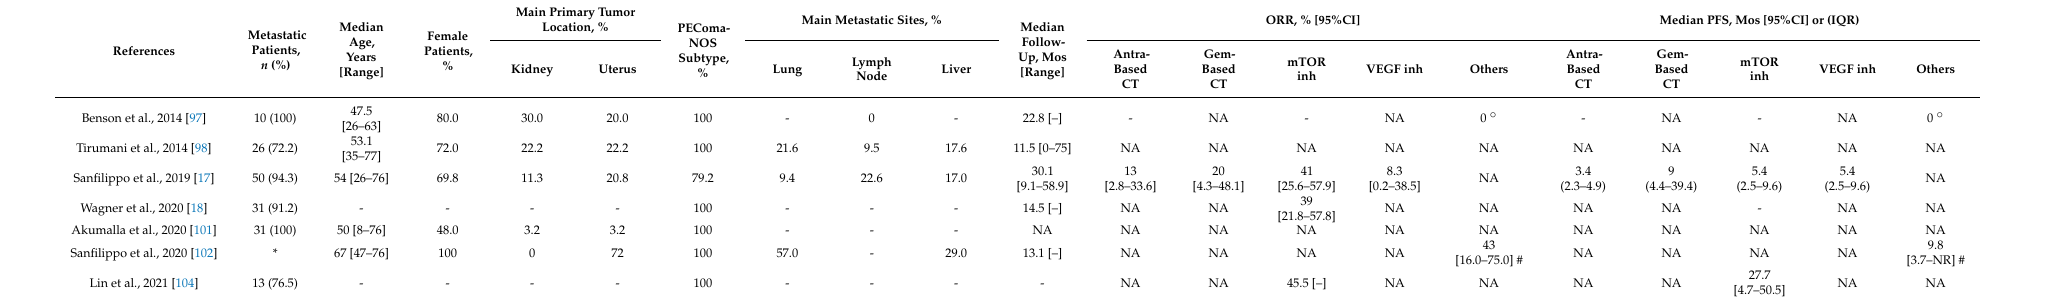
Table 1. Clinical and outcome data from patient